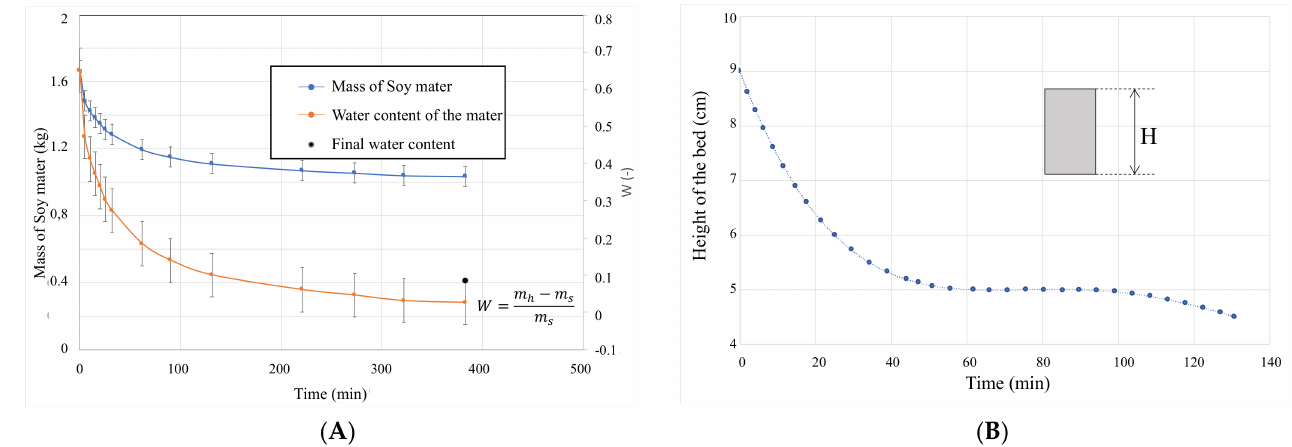
Figure 3. ( A ) Water and mass evolutions during the thick bed-drying process. ( B ) Evolution of the bed height during drying. Operating conditions: air temperature 55 ◦ C; air velocity 1.5 m/s; initial water activity (Wini) 65.0% and final water activity (Wfin)